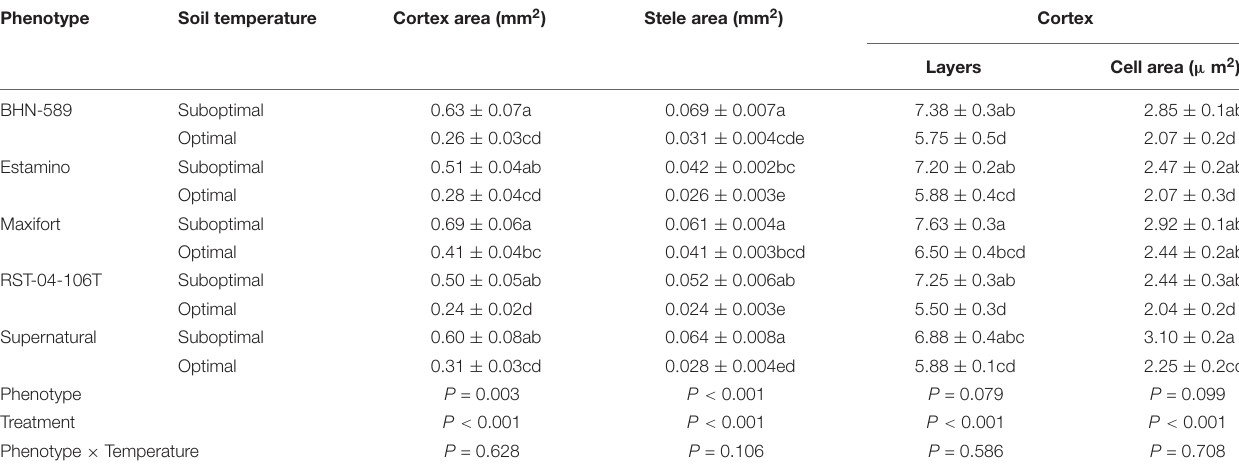
TABLE 1 | Cortex area, stele area, cortical cell layers, and cortical cell area of four grafted rootstocks (Estamino, Maxifort, RST-04-106-T, and Supernatural) and one cultivar (BHN-589) exposed to optimal and suboptimal soil temperatures for 4 weeks.